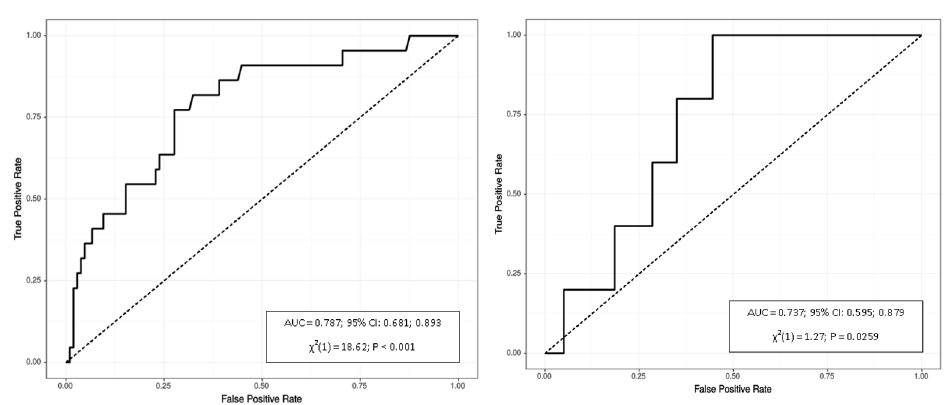
Fig 2. Receiveroperating characteristics of VAT for identifying triglyceride level (cid:21) 150 mg/dL in males (left) and females (right). P refers to logistic regression model.